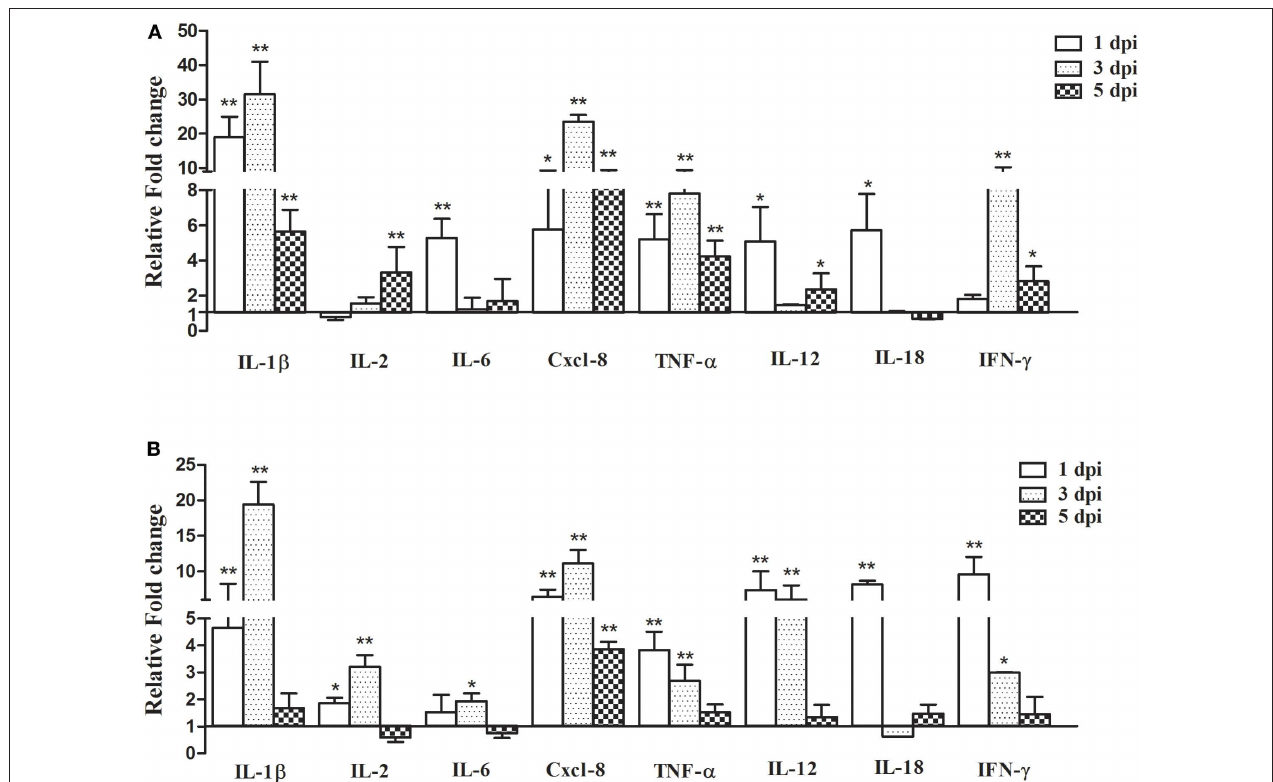
FIGURE 5 | Pro-inflammatory cytokine gene expression in the lungs and spleen after infection with Aspergillus fumigatus . Spleen and right lungs were sampled at 1, 3, and 5 dpi. Gene expressions in infected chickens were expressed as fold change compared to the control group [means ± SD ( n = 3)]. β -actin and GAPDH were used as reference genes. (A,B) were the expression of cytokine gene in the lungs and spleen, respectively. The Y-axis indicates that the relative fold changes of the target gene expression in the Aspergillus fumigatus group vs. those in the control group. * p < 0.05, ** p <